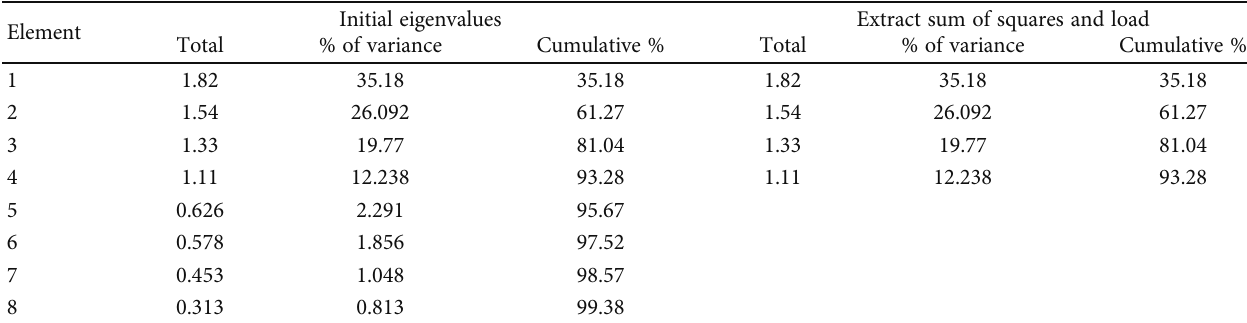
Table 2: The eigenvalues and variance proportions of the thought and moral qualities of university students.